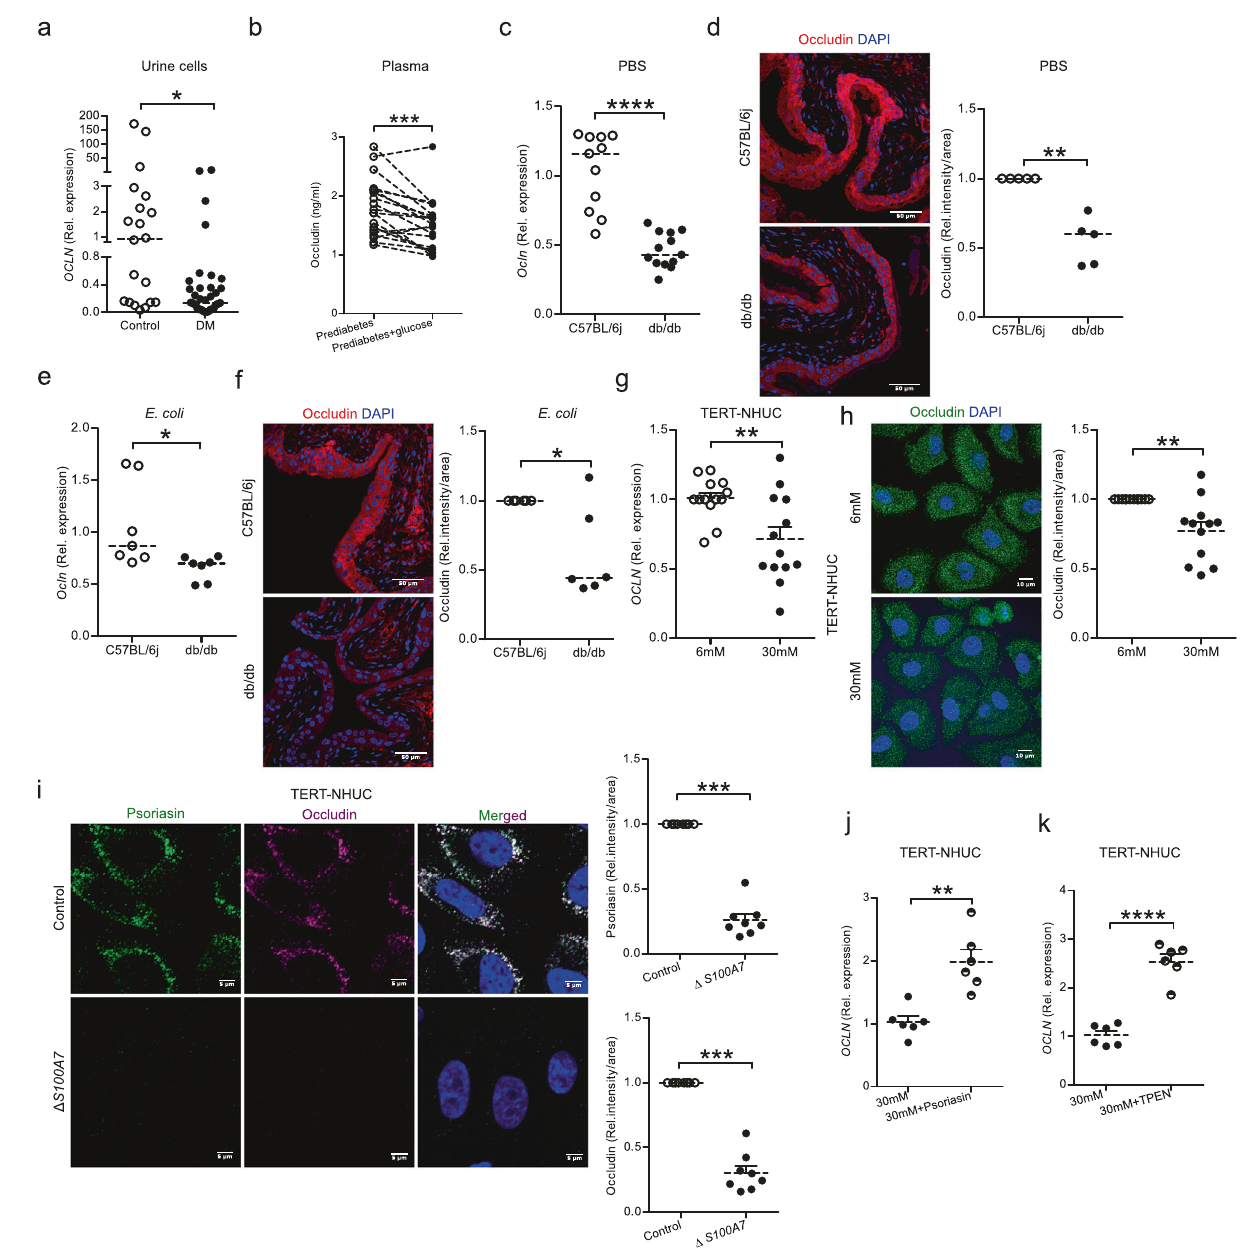
Fig. 3 | Effect of diabetes and high glucose on occludin. a Expression of OCLN mRNA in urine cells from non-diabetic ( n =20) and diabetic patients, DM ( n =36) (unpaired two-tailed t test, p =0.0391). b Plasma occludinlevels inindividuals with prediabetes ( n =20) before and 2h after i.v. glucose infusion (paired two-tailed t test, p =0.0003). Expression of c Ocln mRNA (unpaired two-tailed t test, p ≤ 0.0001) and d protein in PBS treated diabetic, db/db ( n =13; n =5) and non- diabetic, C57BL/6j ( n =11; n =5) mice respectively (Mann-Whitney two-tailed test, p =0.0075).Expressionof e Ocln mRNA(unpairedtwo-tailedttest, p =0.0289)and f protein in 24h E. coli infected db/db and C57BL/6j mice ( n =7; n =6 each) respectively (Mann-Whitney two-tailed test, p =0.0493). g Expression of OCLN mRNA level in TERT-NHUC uroepithelial cells cultured with glucose (normal=6 mM: high=30mM) for 24h ( n =13) (unpaired two-tailed t test, p =0.0059). h Representative microscopy image of occludin after 36h glucose treatment